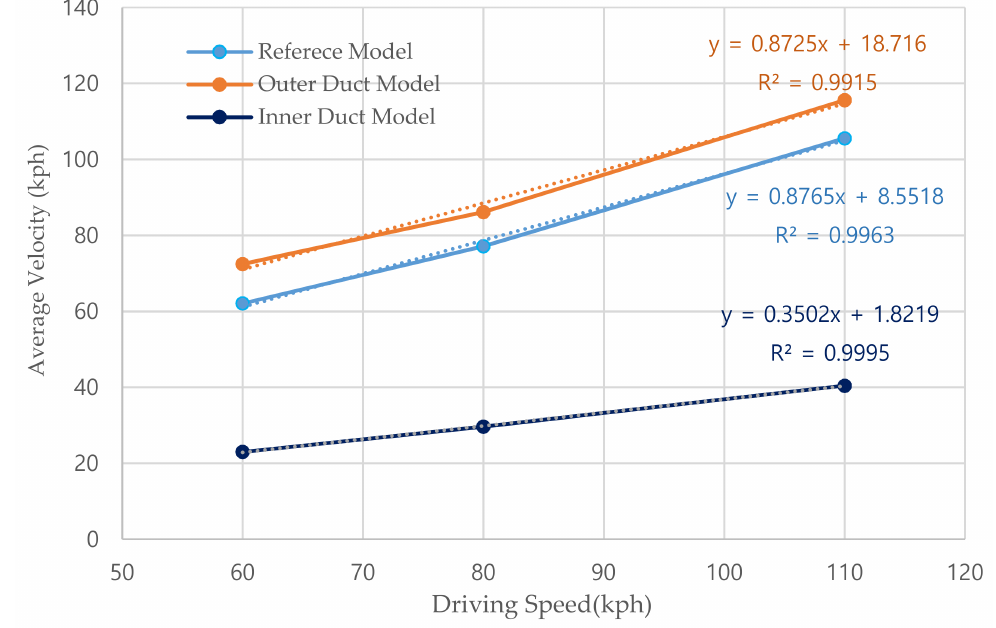
Figure 7. Comparisons of the average velocity and the increasing rate of the three OSRVM models for the three driving speeds.